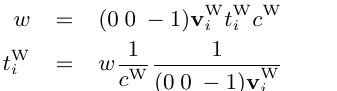
Figure 1. Schematic diagram of redundant bed observations from different view points. Due to beam refraction at the air-water-interface (blue dashed line) the uncorrected profiles (green and red dashed lines) are displaced in horizontal and vertical direction against the true water bottom (black solid line).